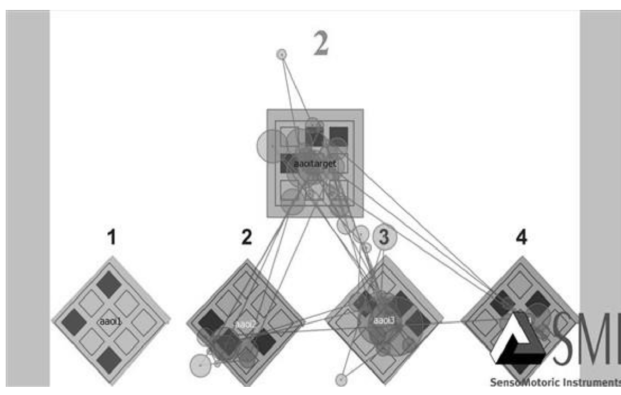
Figure 2. Eye Movement Measures on Slide 2 of the CWMR Test. Aaoitarget = the Target area; Aaoi1 to Aaoi4 = the Answers area; Each line represents transition (saccade), and each circle represents